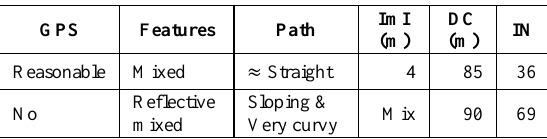
Table 1: Tests description